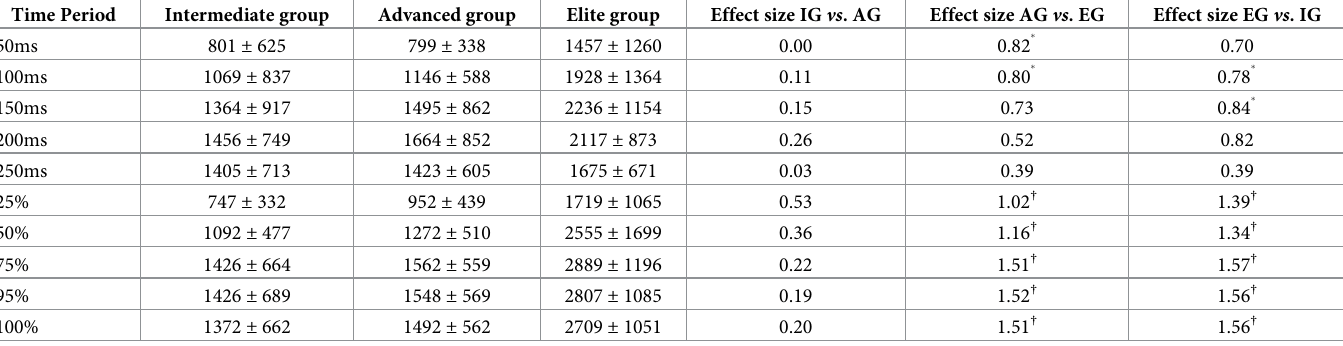
Table 3. The rate of force development (Newton × s -1 ) from the best attempt for the elite intermediate (IG), advanced (AG) and elite groups (EG) and the effect sizes for the between groups differences. Time